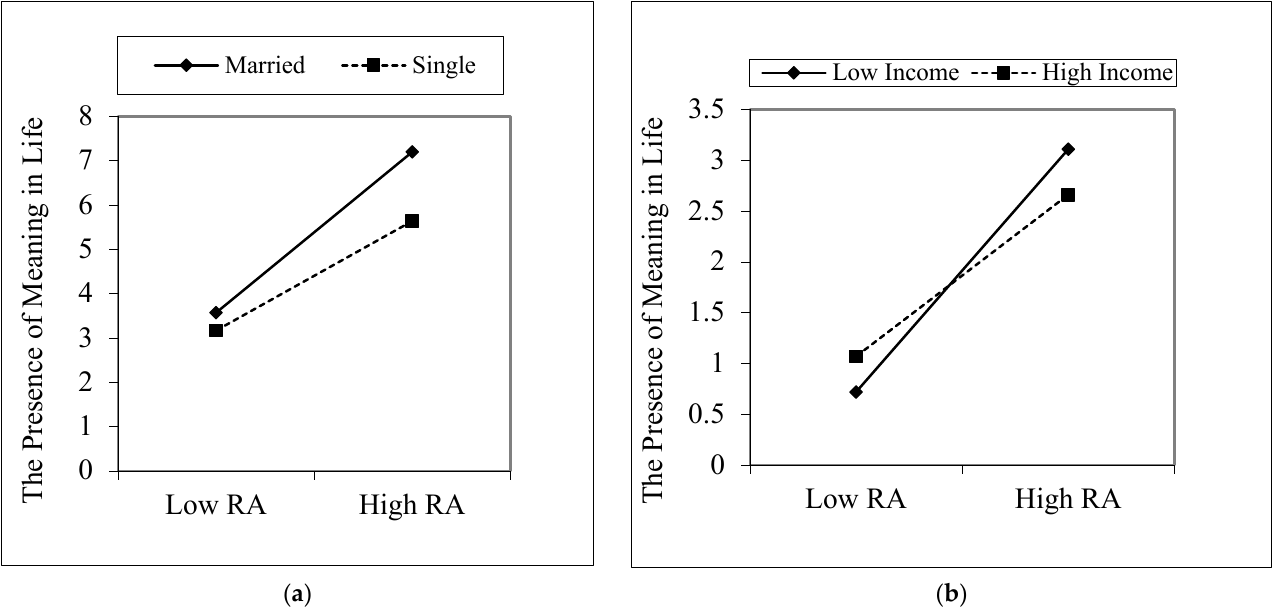
Figure 2. Interaction effects of RA and Marital St. on PML ( a ) and RA and Income St. on PML ( b ).